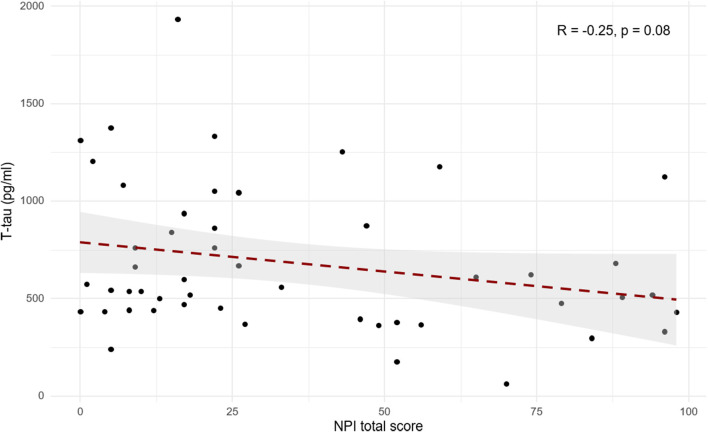
Scatterplot of Pearson’s correlation between cerebrospinal fluid (CSF) t-tau and NPI total score in patients with primary dementia (AD, FTD, and LBD).